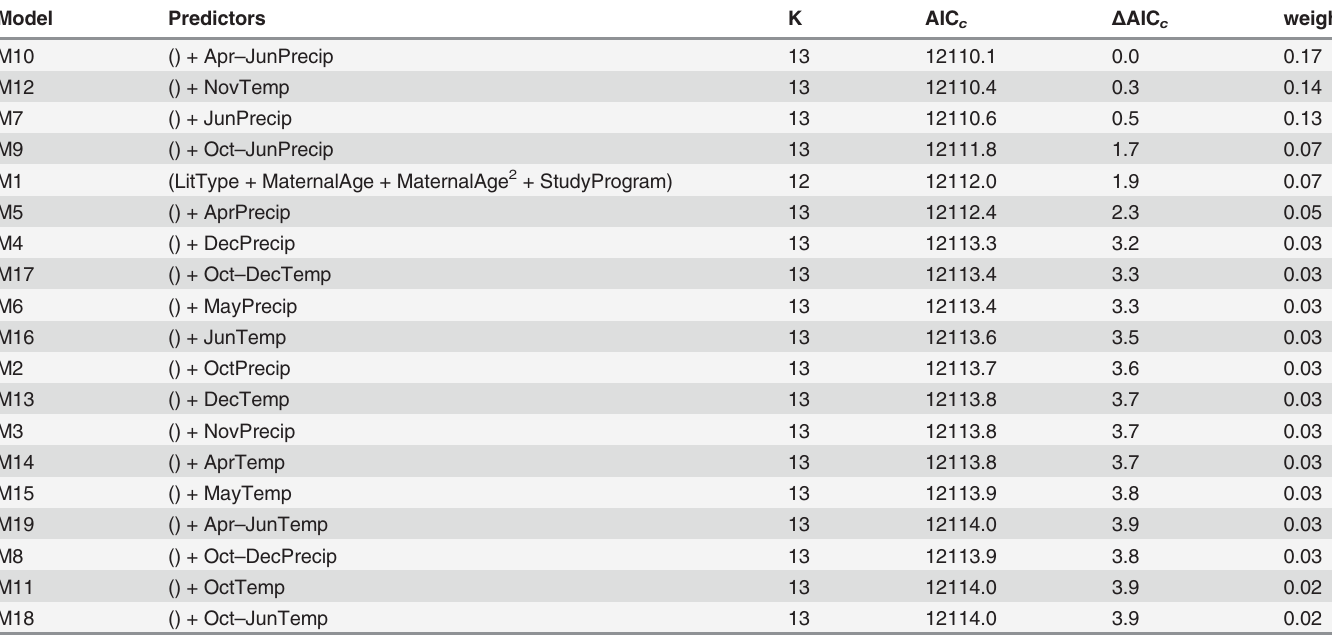
Table 2. Models analyzed and summaries of model selection for the influence of biological variables (litter type, maternal age, study program), and environmental variables on parturition date (Julian date) of penned white-tailed deer from the Kerr Wildlife Management Area, Kerr County, TX from 1977 – 2012.